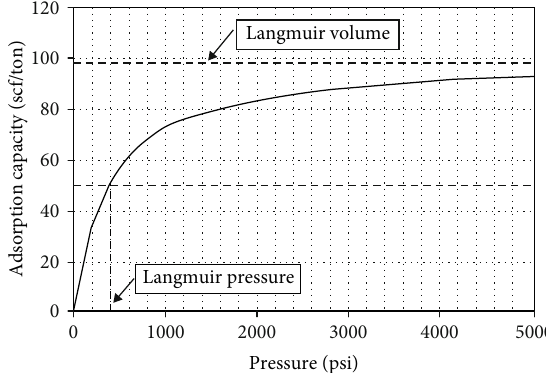
Figure 3: Langmuir isothermal adsorption